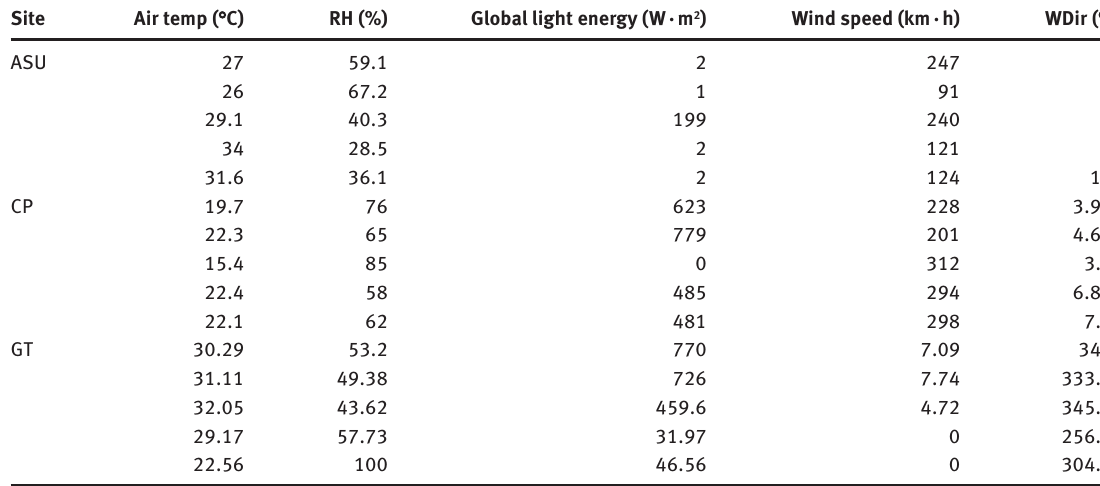
Table 1: Samples from the Three Wind Speed Datasets. Site